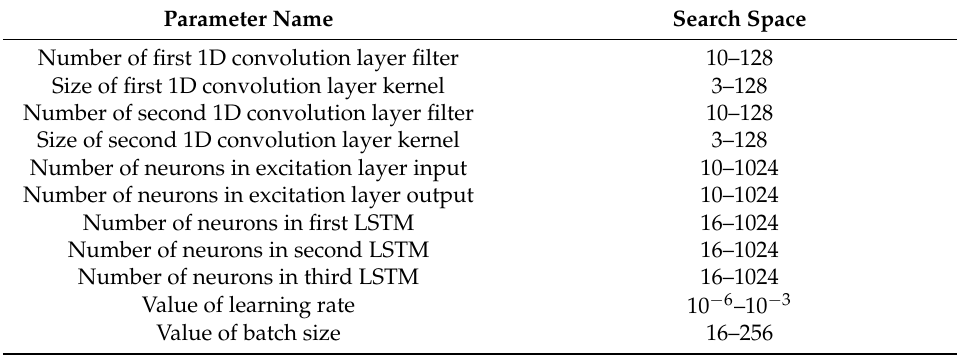
Table 3. Search space of the CNN-LSTM with the SE model.